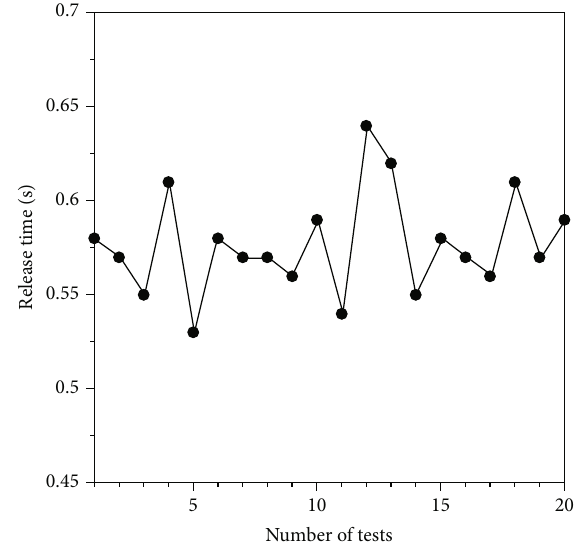
Figure 8: Time histories of the input voltage, separation signal, and acceleration response obtained from release test of the solar panel.